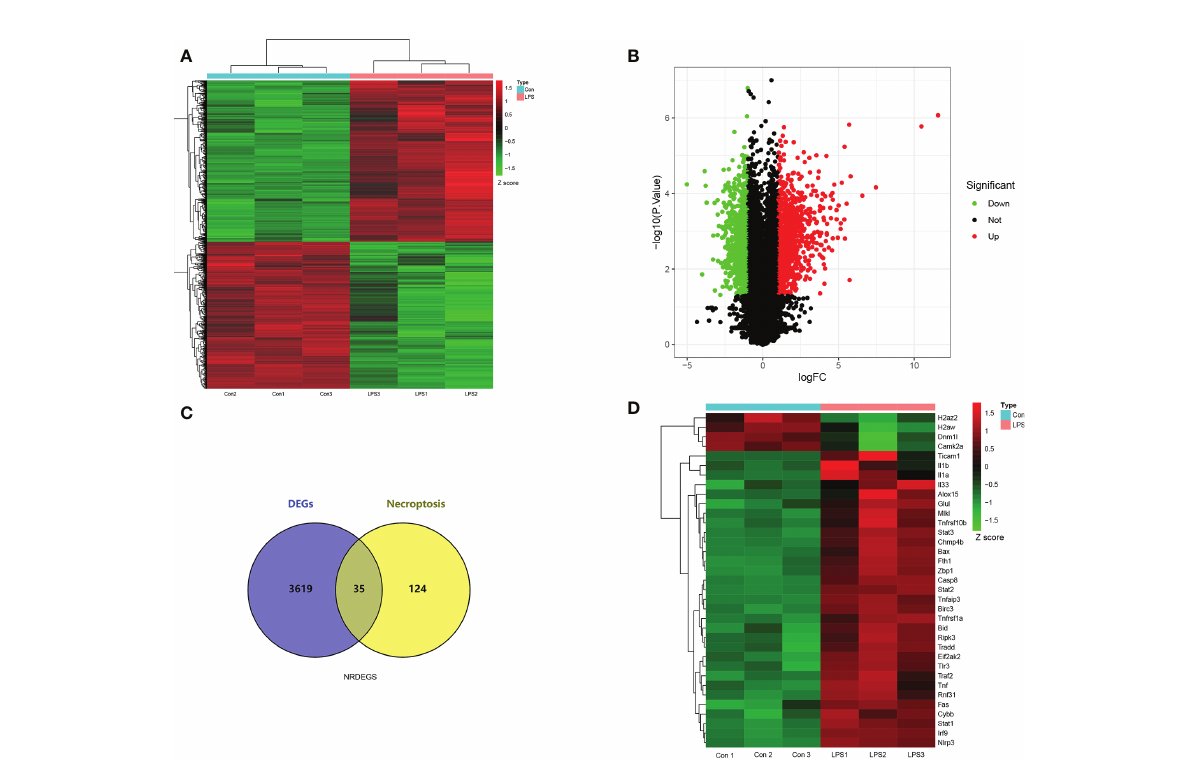
FIGURE 3 Screening of necroptosis-related differentially expressed genes (NRDEGs) in SIMD. (A) Heatmap shows the relative expression of the DEGs in the control and SIMD groups. Red denotes up-regulated genes, and green denotes downregulated genes. (B) Volcano map shows the RNA sequencing results. The green dots represent downregulated genes; the red dots represent up-regulated genes; the black dots represent unchanged genes. (C) Venn diagram shows the overlap between DEGs and necroptosis-related genes in the Kyoto Encyclopedia of Genes and Genomes pathway database. (D) Clustered heatmap of the